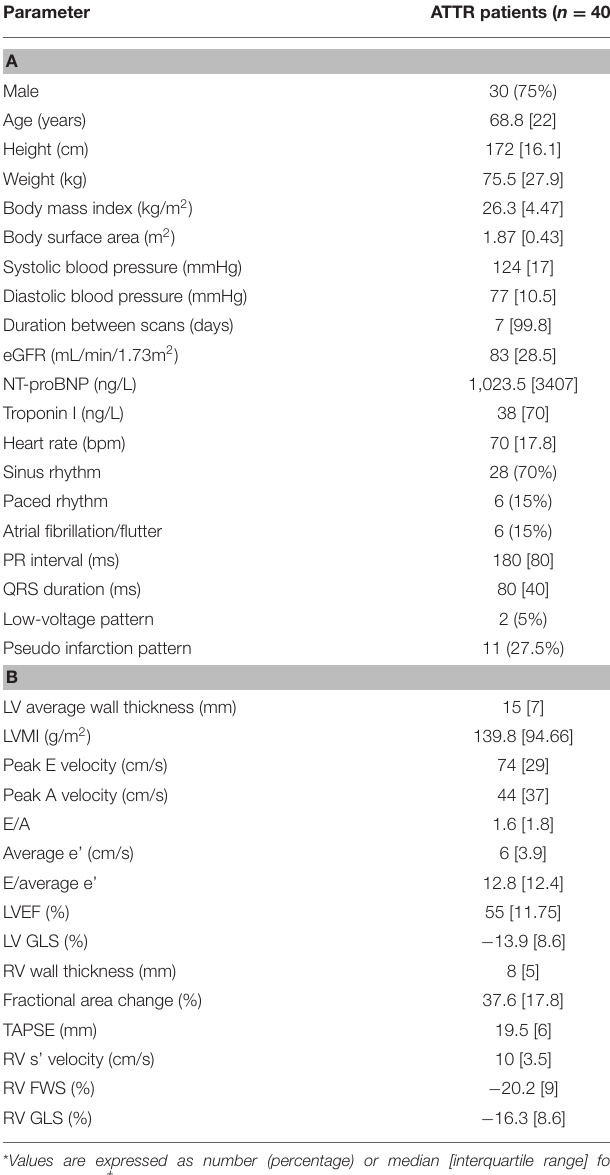
TABLE 1 | (A) Demographics, biochemical, electrocardiogram and (B) echocardiographic parameters for ATTR patients. Parameter